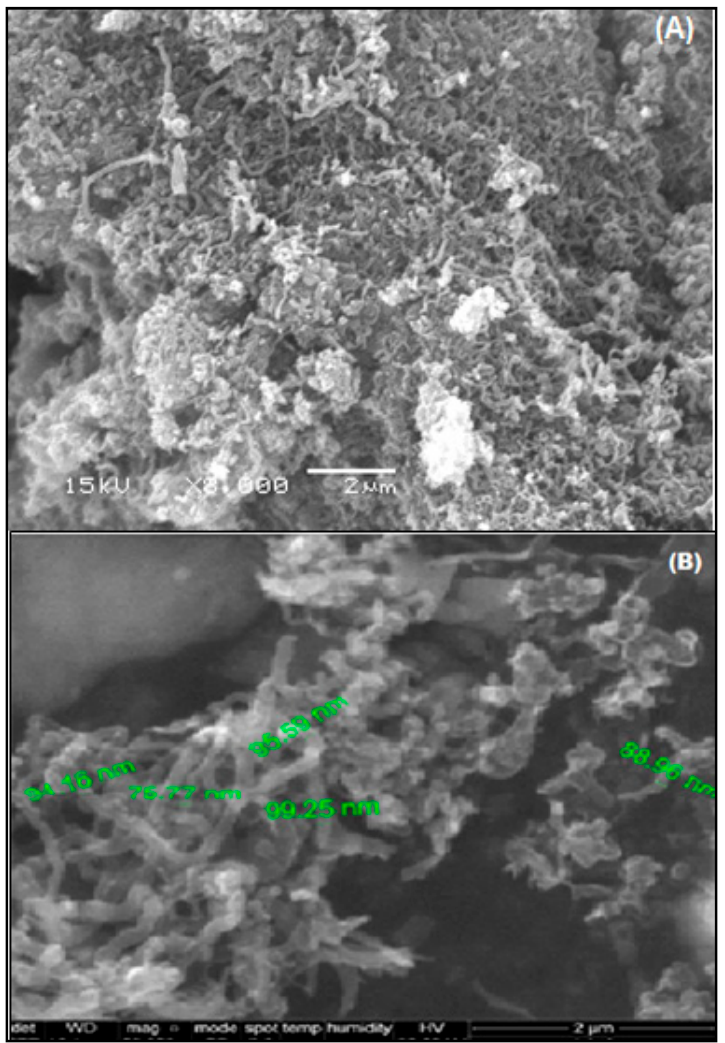
Figure 3. SEM examination at 2 µm and magnification (8000×) for the prepared ( A ) and purified ( B ) MWCNTs.